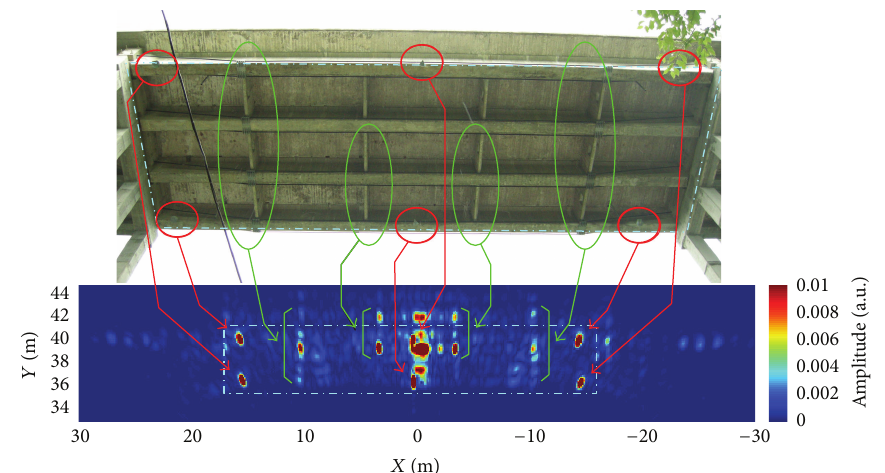
Figure 15: Amplitude radar image with the targets highlighted in the corresponding picture of the span.